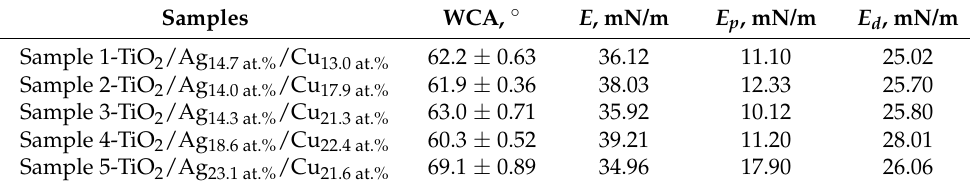
Table 2. Water contact angle, WCA, surface energy, E and its polar E p , and disperse part, E d of TiO 2 /Ag/Cu composite coatings both with almost equal Ag content and varied Cu content (Samples 1, 2 and 3) or with almost equal coper content and varied silver content (samples 2, 4, and 5). Samples WCA, ◦ E , mN/m E p , mN/m E d , mN/m Sample 1-TiO 2 /Ag 14.7 at.% /Cu 13.0 at.% 62.2 ± 0.63 36.12 11.10 25.02 Sample 2-TiO 2 /Ag 14.0 at.% /Cu 17.9 at.% 61.9 ± 0.36 38.03 12.33 25.70 Sample 3-TiO 2 /Ag 14.3 at.% /Cu 21.3 at.% 63.0 ± 0.71 35.92 25.80 Sample 4-TiO 2 /Ag 18.6 at.% /Cu 22.4 at.% 60.3 ± 0.52 39.21 11.20 28.01 Sample 5-TiO 2 /Ag 23.1 at.% /Cu 21.6 at.% 69.1 ± 0.89 34.96 17.90